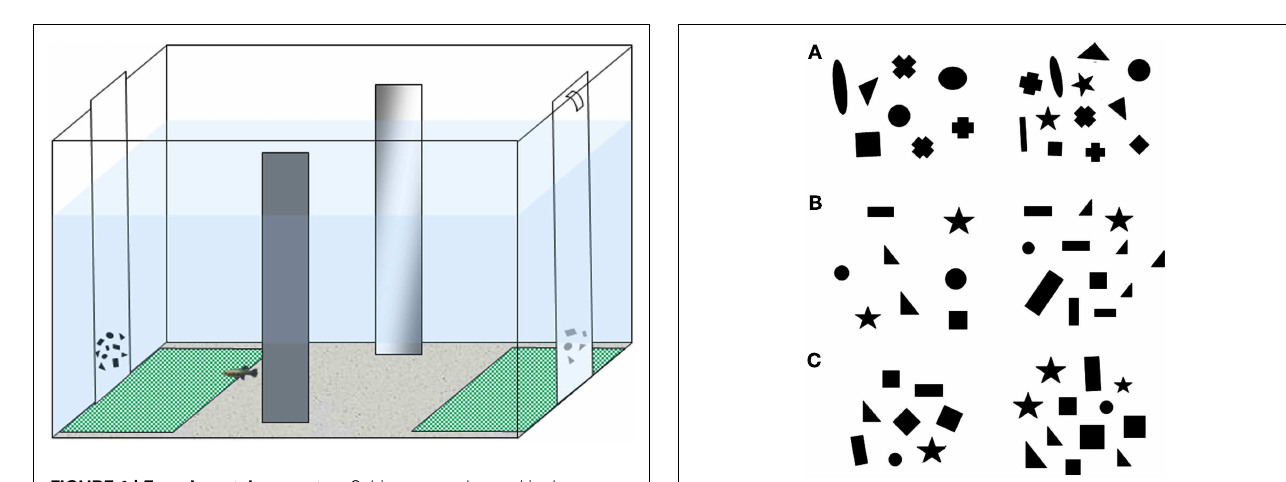
the same ratio (0.50), but very different total set size (2 vs. 4 and 25 vs.